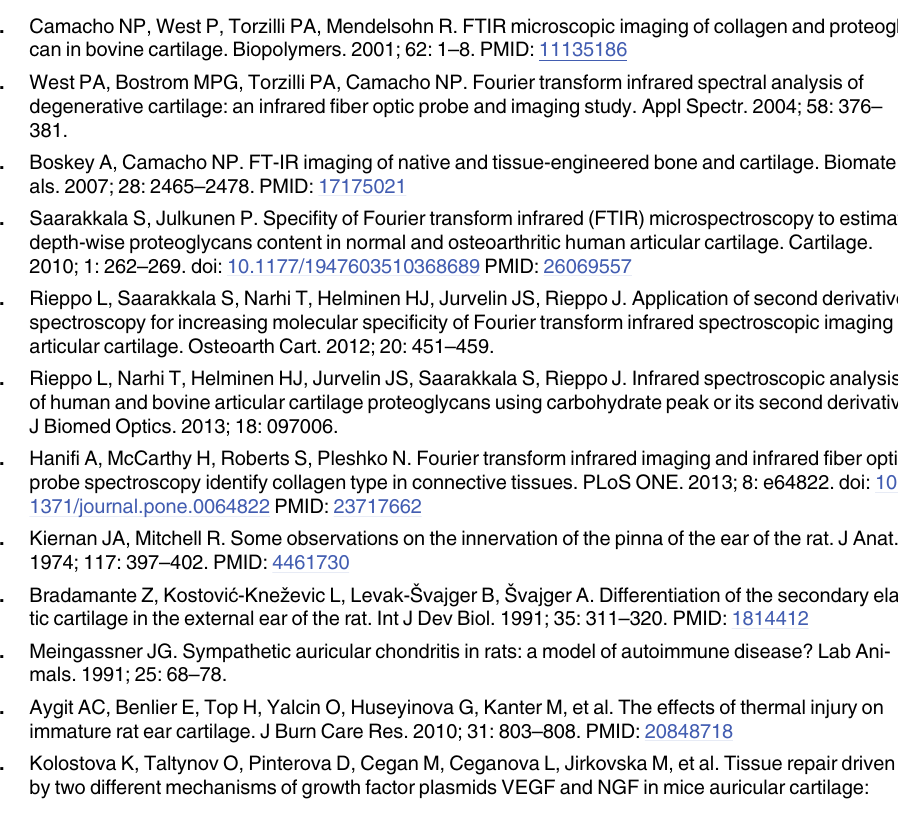
S3 Fig. FT-IR spectral profiles for untreated (black line) and hyaluronidase-treated (pink line) ear cartilage ECM. The spectrum represented by the pink line, which was not normalized with respect to the amide I band, shows changes introduced by hyaluronidase treatment in amide I and II regions. (TIF) S4 Fig. FT-IR spectral profiles for ear cartilage ECM (A, black line), 4-CIS (A and B, navy line) and collagen II (B, green line). Details for the 1450 – 700 cm -1 window. A (Y axis), absor- bances. (TIF) S1 Table. Numerical integral statistics applied to the FT-IR spectra obtained for rat ear car- tilage and normalized to amide I using Grams